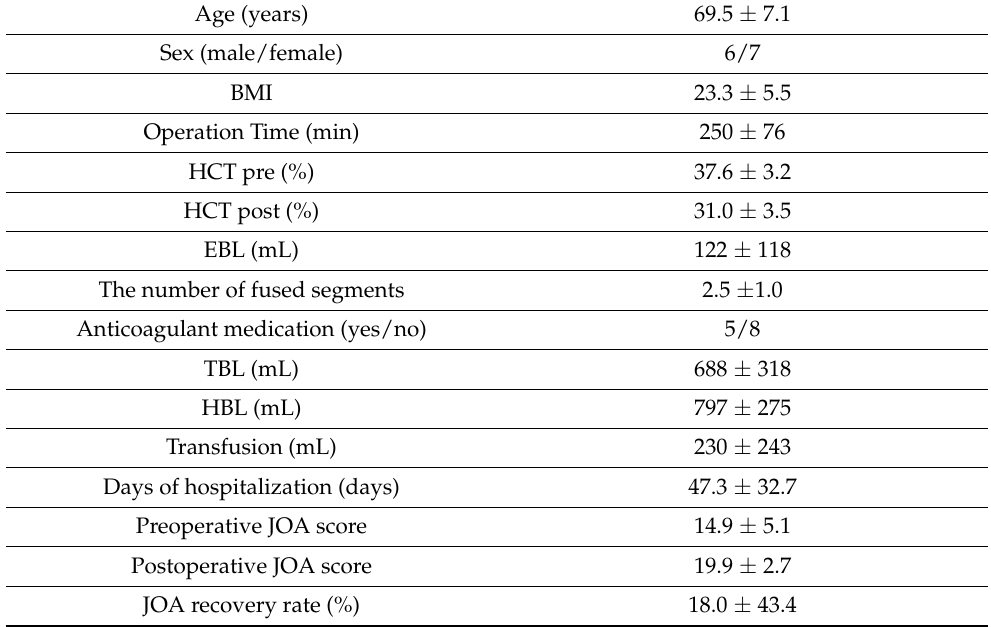
Table 1. Patient demographics.